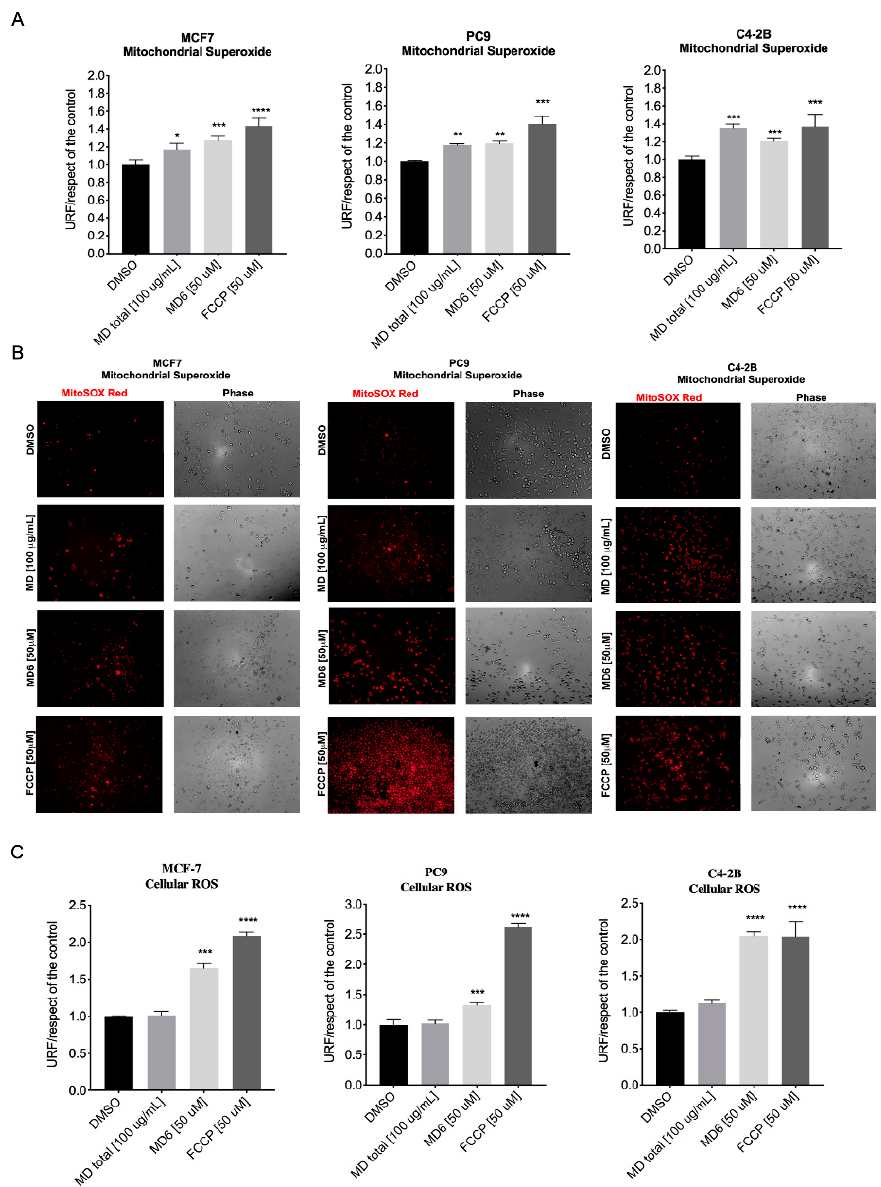
Figure 8. Effect of MD and MD-6 on mitochondrial and cell ROS generation in human cancer cells. MCF-7, PC9, and C4-2B cells were treated with 100 µg/mL MD extract, 50 µM MD-6, or 50 µM FCCP for 6 h. Mitochondrial superoxide and cell ROS levels were analyzed using MitoSOX Red and CM-H2DCFDA probes, respectively. ( A ) Mitochondrial superoxide determination by fluorimetry, ( B ) epifluorescence microscopy, the microphotographs were acquired with an Olympus IX81 DSU microscope (20× magnification). ( C ) Cell ROS determination by fluorimetry. The data represent the means ± S.D. of three independent experiments performed in triplicate, and statistically analyzed using one-way analysis of variance and Dunnett’s post-test; (**** p ≤ 0.0001, *** p ≤ 0.001, ** p ≤ 0.01, * p ≤ 0.05).